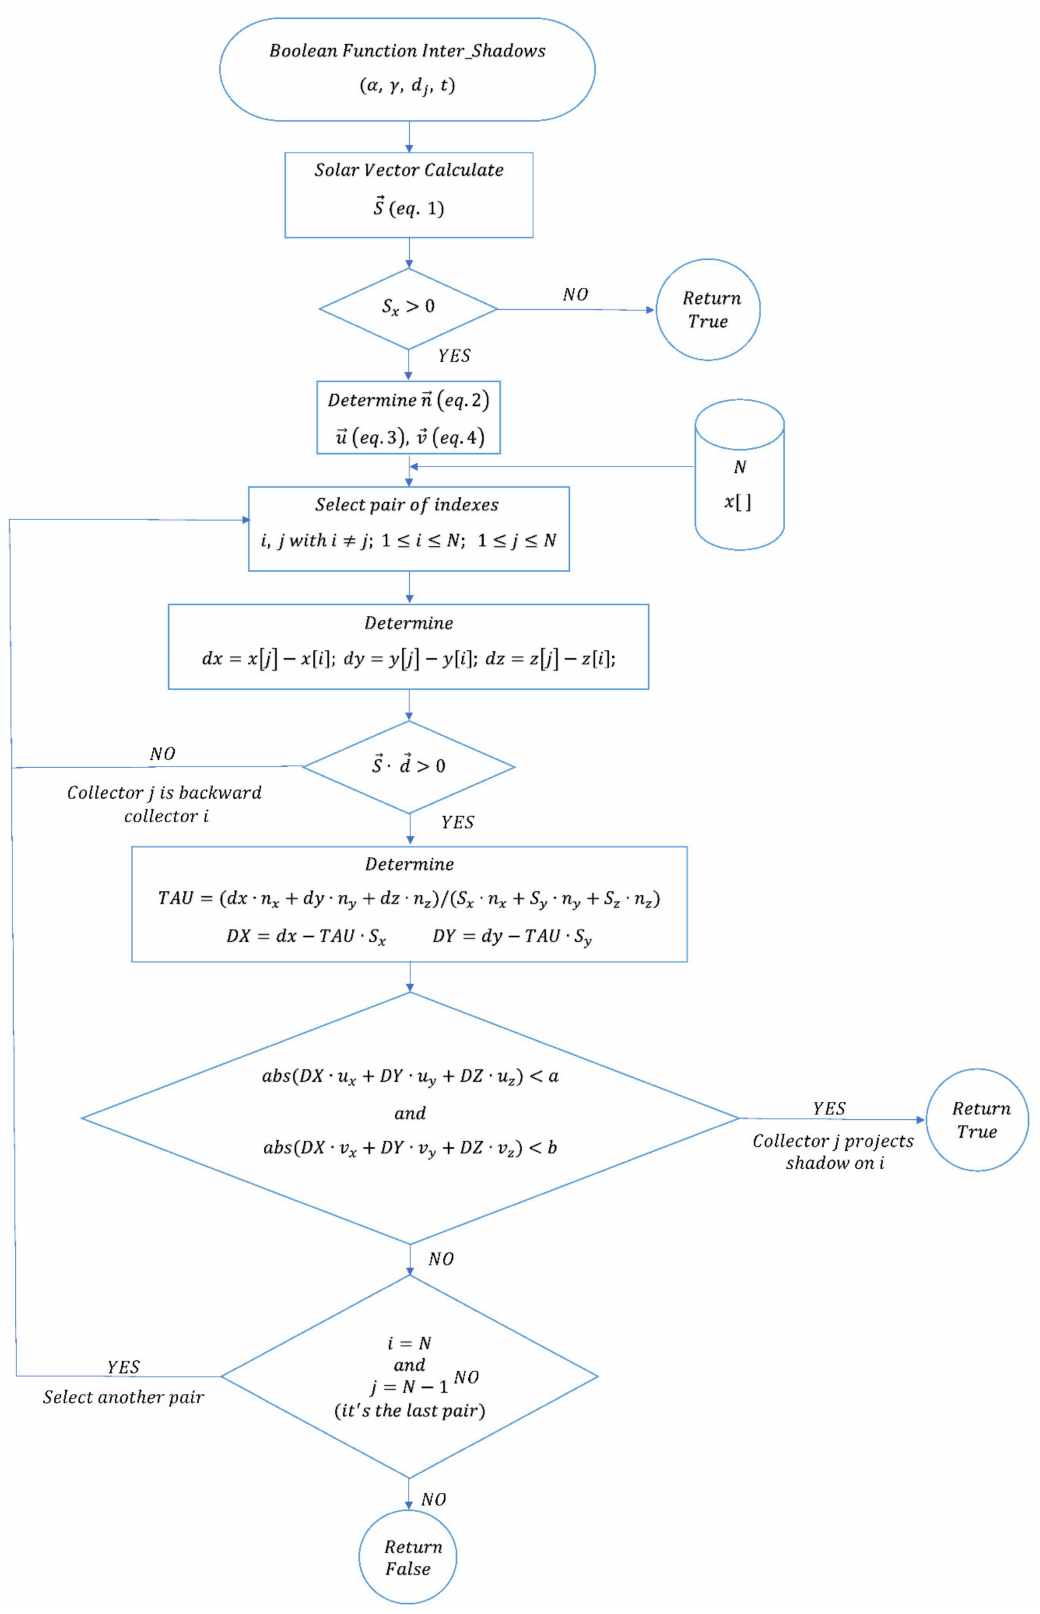
Figure 2. Flow chart of the designed